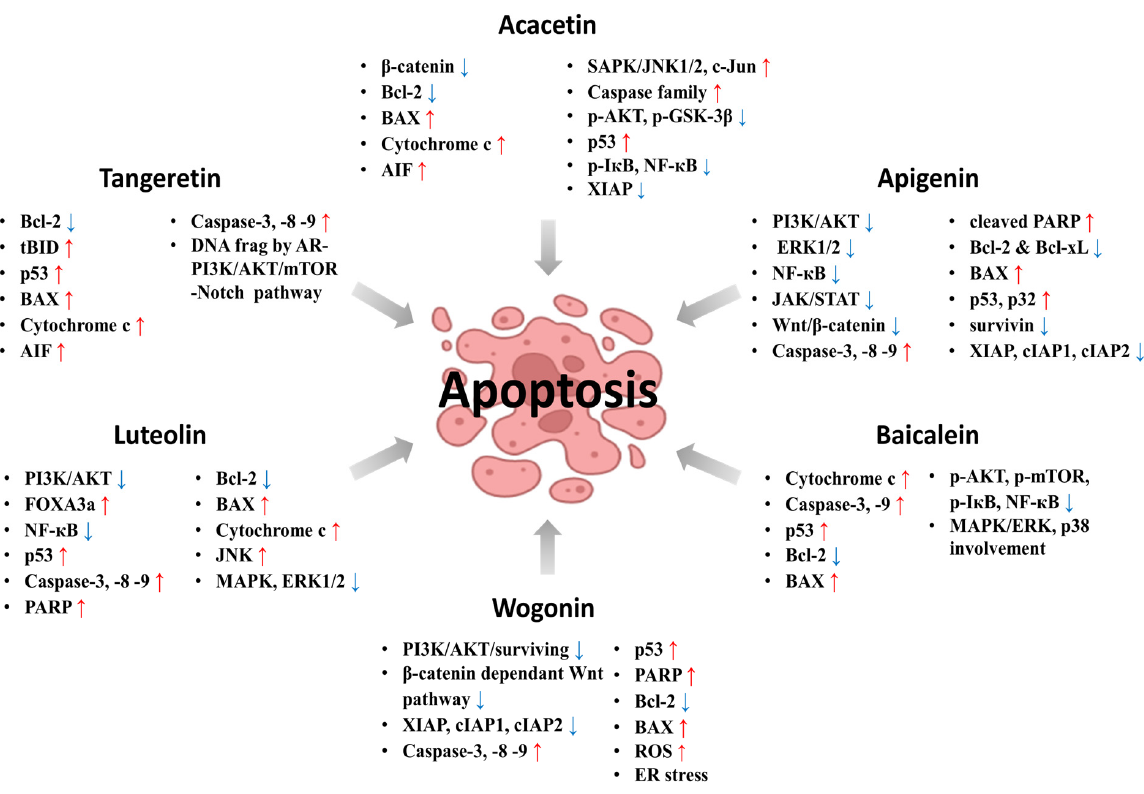
Figure 5. Up- and downregulation of related pathways and proteins in which cancer cells undergo apoptosis by flavones. Table 3. Relationship between flavones and signaling pathways leading to apoptosis in various cancer